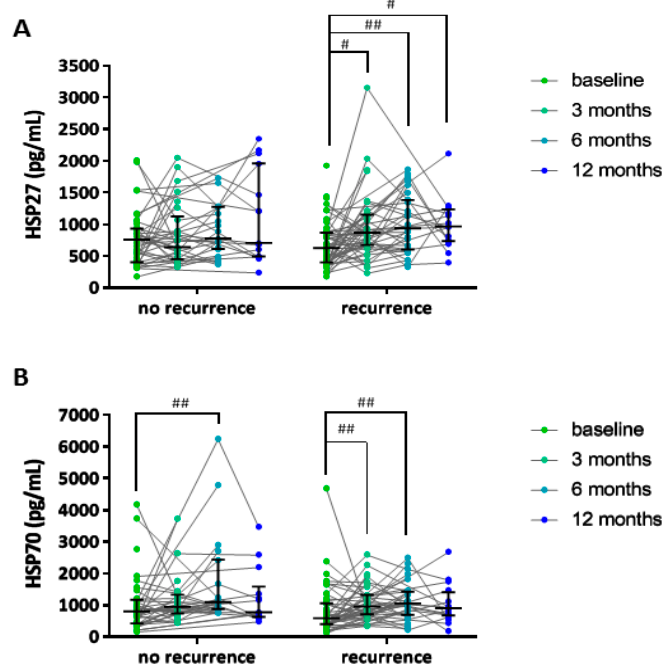
Figure 4. HSP27 and HSP70 levels in follow-up serum were higher than baseline in patients having AF recurrence. HSP27 serum levels (pg / mL) at baseline and at 3-, 6- and 12-months follow-up in patients having AF recurrence within one year, compared to patients not having AF recurrence ( A ). HSP70 serum levels (pg / mL) at baseline and at 3-, 6- and 12-months follow-up in patients having AF recurrence within one year, compared to patients not having AF recurrence ( B ). # p < 0.05 and ## p < 0.01 compared to baseline serum HSP levels. Table 2. Outcomes joint modeling of AF recurrence in relation to HSP levels, and sensitivity analyses. Patients